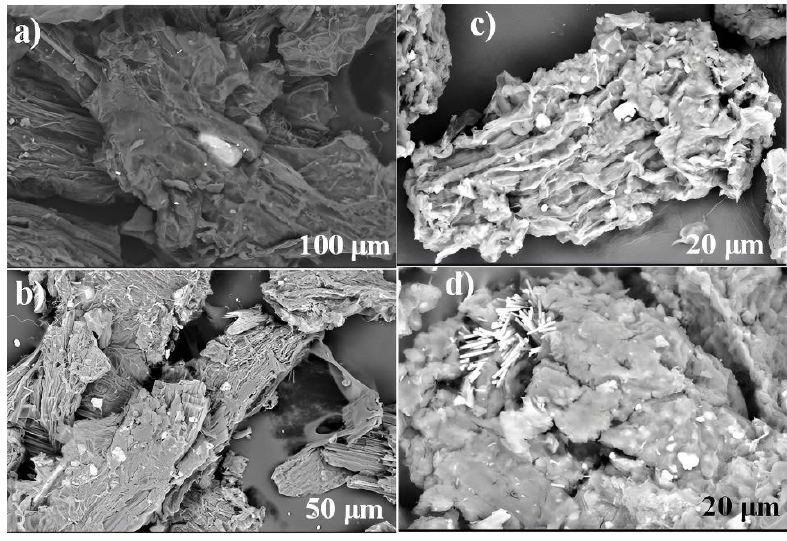
Figure 7. SEM micrographs of WLW after adsorption: for PR ( a , b ); for GV ( c , d ).